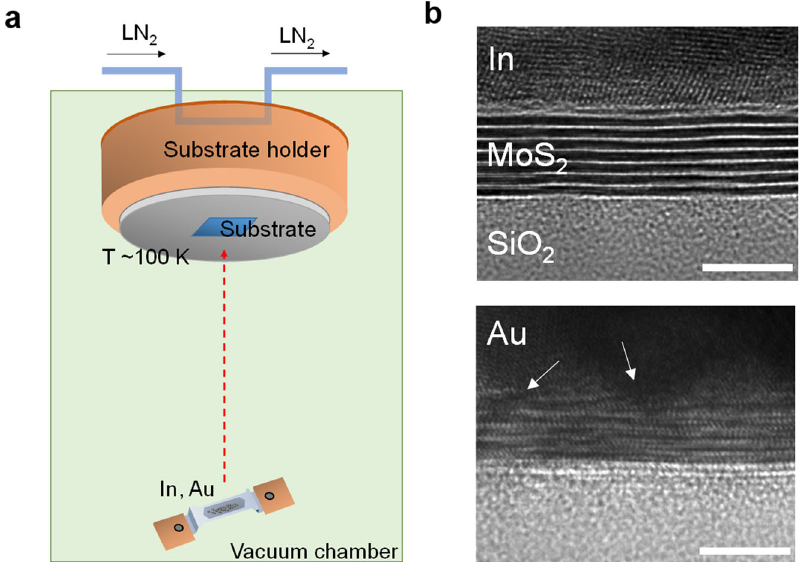
Fig. 1 Metal deposition on MoS 2 . a In (Au) evaporation in a vacuum chamber with a liquid-nitrogen cooled sample holder. b Top and bottom: cross-sectional TEM images of the In/MoS 2 and Au/MoS 2 interfaces, respectively. Scale bar: 5